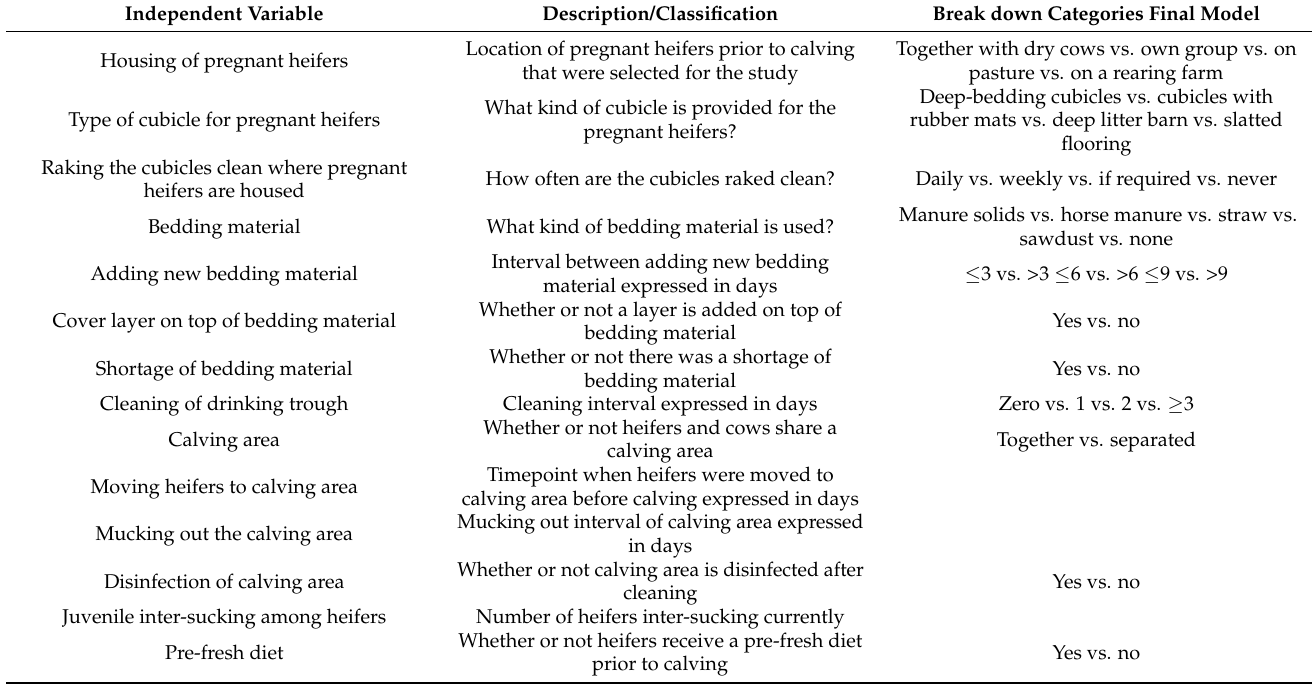
Table A2. Management-related questions raised in the interview about possible risk factors prior to